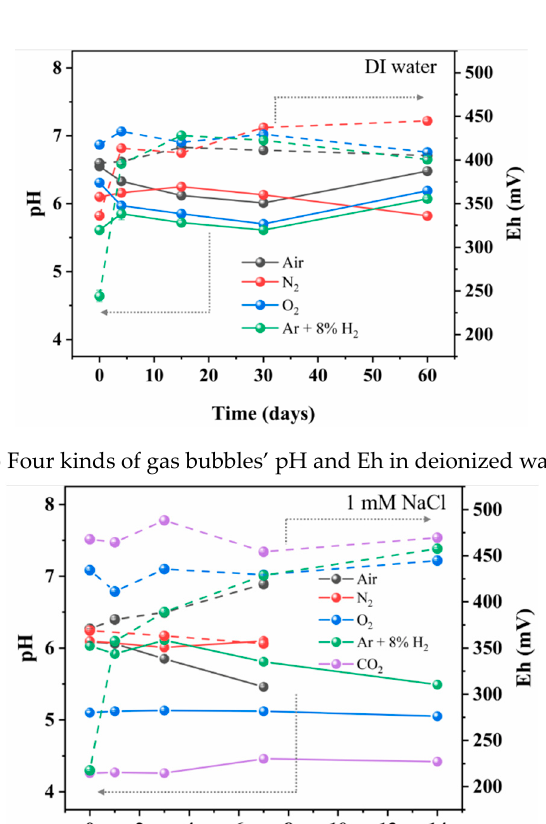
Figure 4. Effect of time on nanobubble zeta potential of different kind of gases (N 2 , O 2 , Ar + 8%H 2 , air and CO 2 ) in ( A ) deionized water, ( B ) 1 mM NaCl aqueous solution, ( C ) 1 mM CaCl 2 aqueous solution and ( D ) 1 mM AlCl 3 aqueous solution.